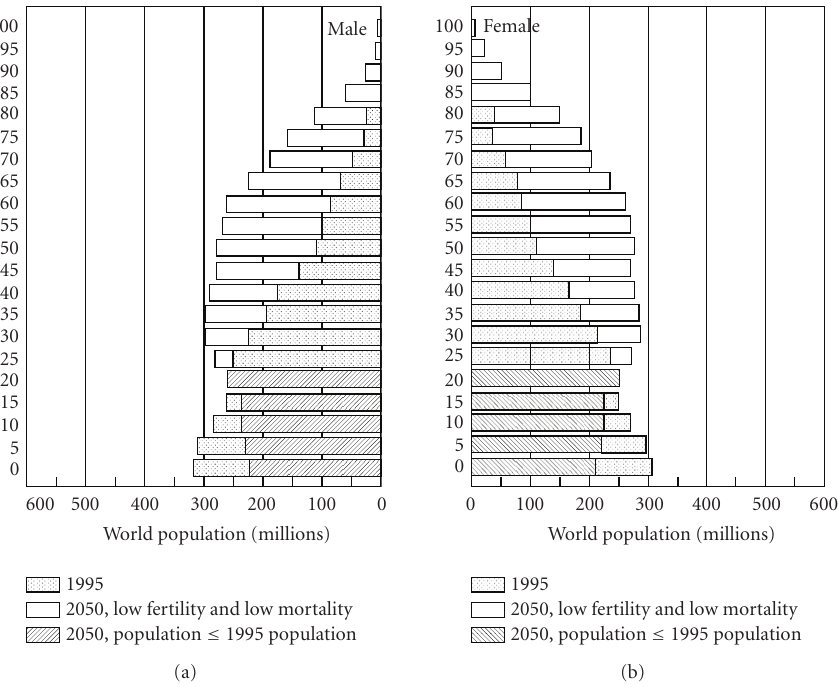
Figure 1: Global population pyramid (adopted from International Institute for Applied Systems